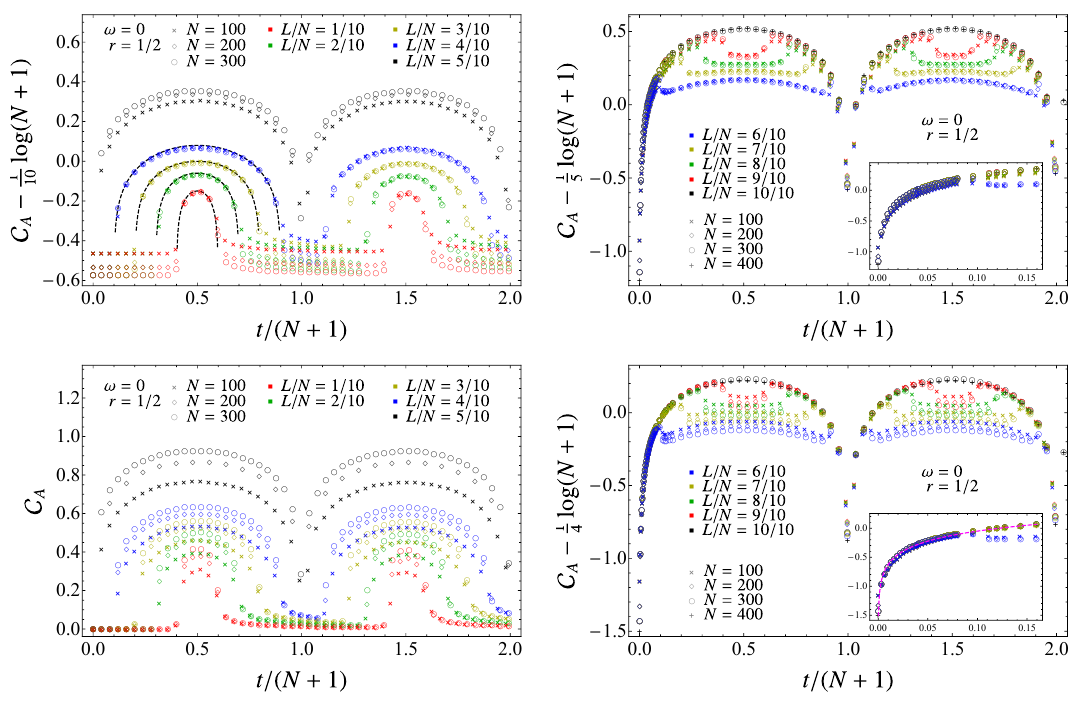
Figure 6 . Temporal evolution of the subsystem complexity C A in (4.4) for a block A made by L consecutive sites adjacent to the left boundary of harmonic chains made by N sites (see figure 1, bottom left panel) after a local quench with ω = 0 and r = 1 / 2 . The size of the blocks is L 6 Nr in the left panels and L > Nr in the right panels. The black dashed curves in the top left panel correspond to (4.6). The insets zoom in on the initial growth (the dashed curve in the bottom right panel corresponds to (3.25)). The data points corresponding to L/N = 1 in the right panels are also reported in the top left panel of figure